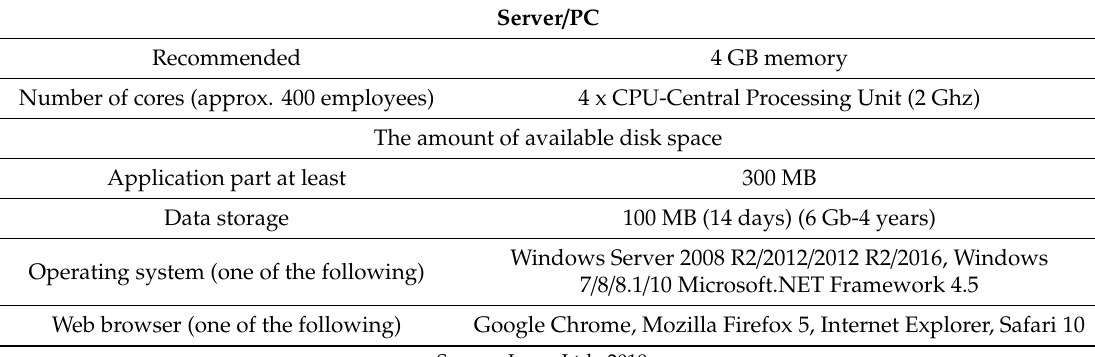
Table 7. Minimum requirements for the MYQ